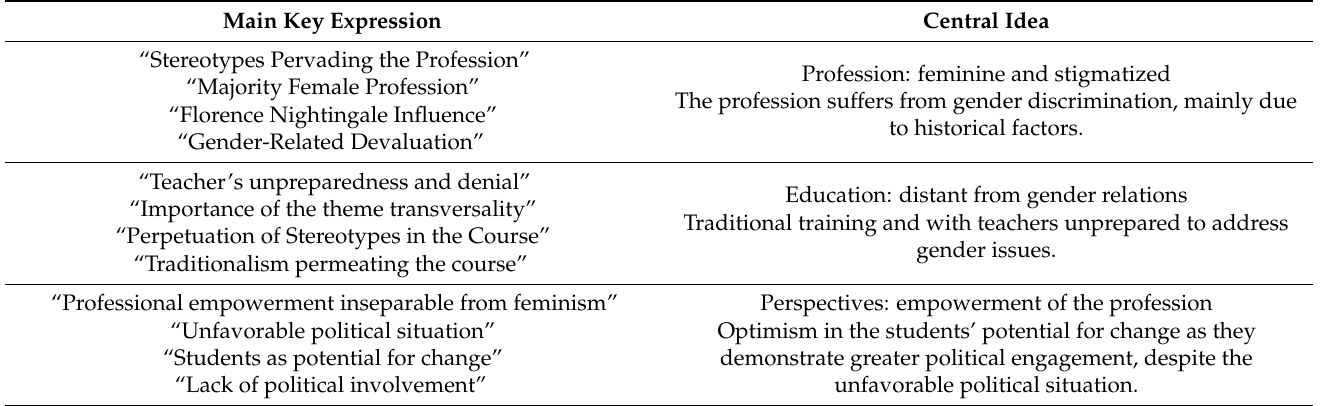
Table 2. Central ideas from the key